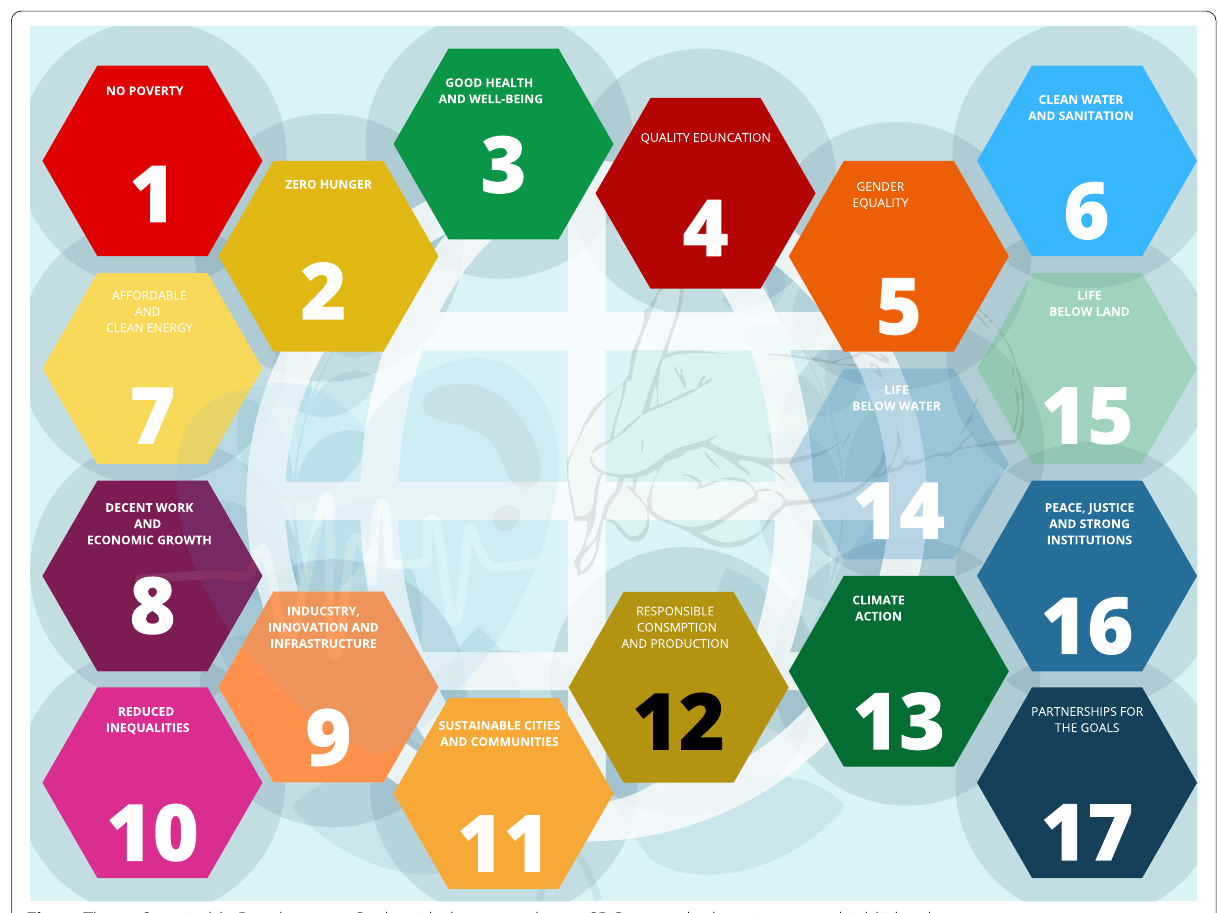
Fig. 1 The 17 Sustainable Development Goals, with the most relevant SDGs to cardiothoracic surgery highlighted